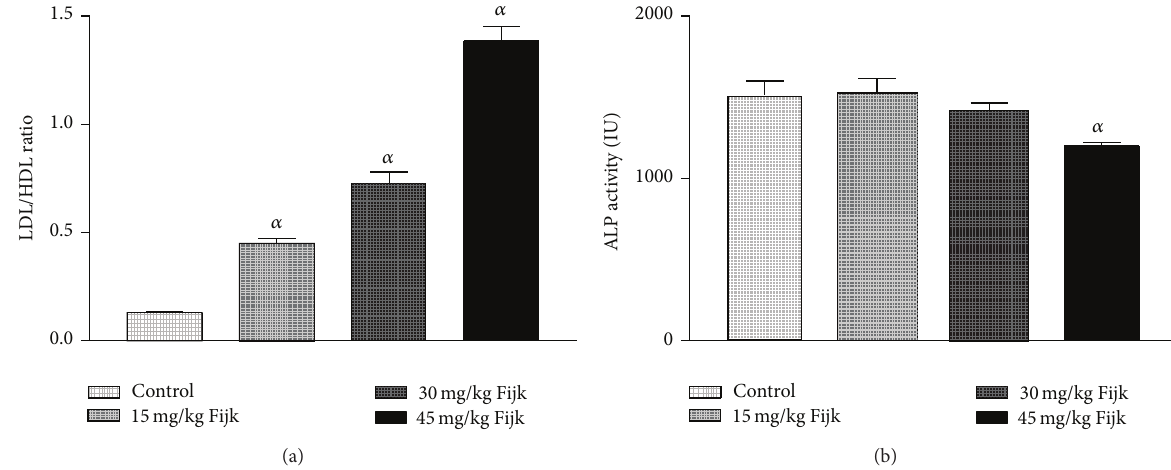
Figure 4: (a) Atherogenic index in rats following repeated and oral exposure to Fijk herbal at different dosages; (b) level of rat plasma alkaline phosphatase following repeated and oral exposure to Fijk herbal at different dosages. Data are presented as mean value ± standard error of mean (SEM), 𝑛 = 6 . 𝛼 is significant at 𝑃 < 0.05 relative to